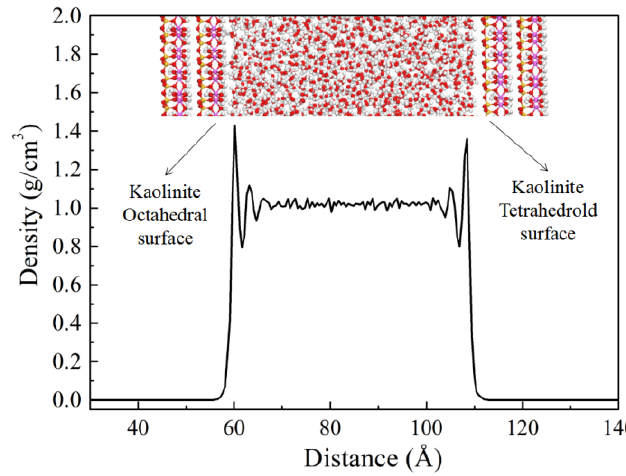
Figure 15. Density distribution of water on the O and T surface of kaolinite.